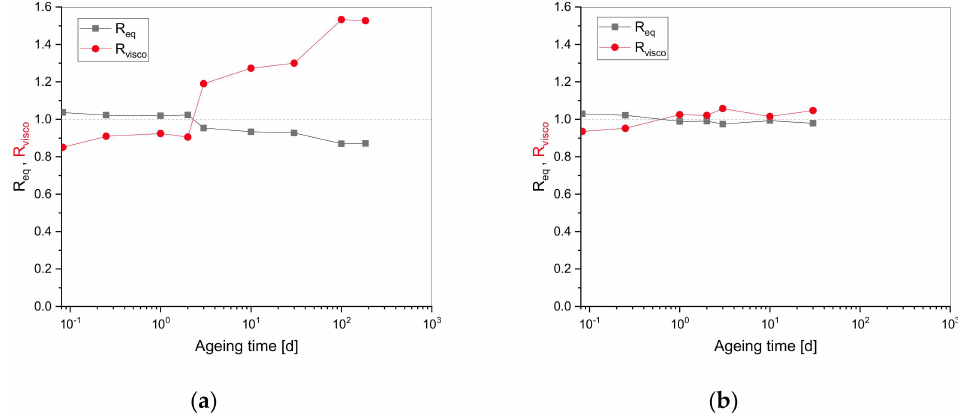
Figure 5. Influence of the viscoelastic contribution for ( a ) EPDM and ( b )